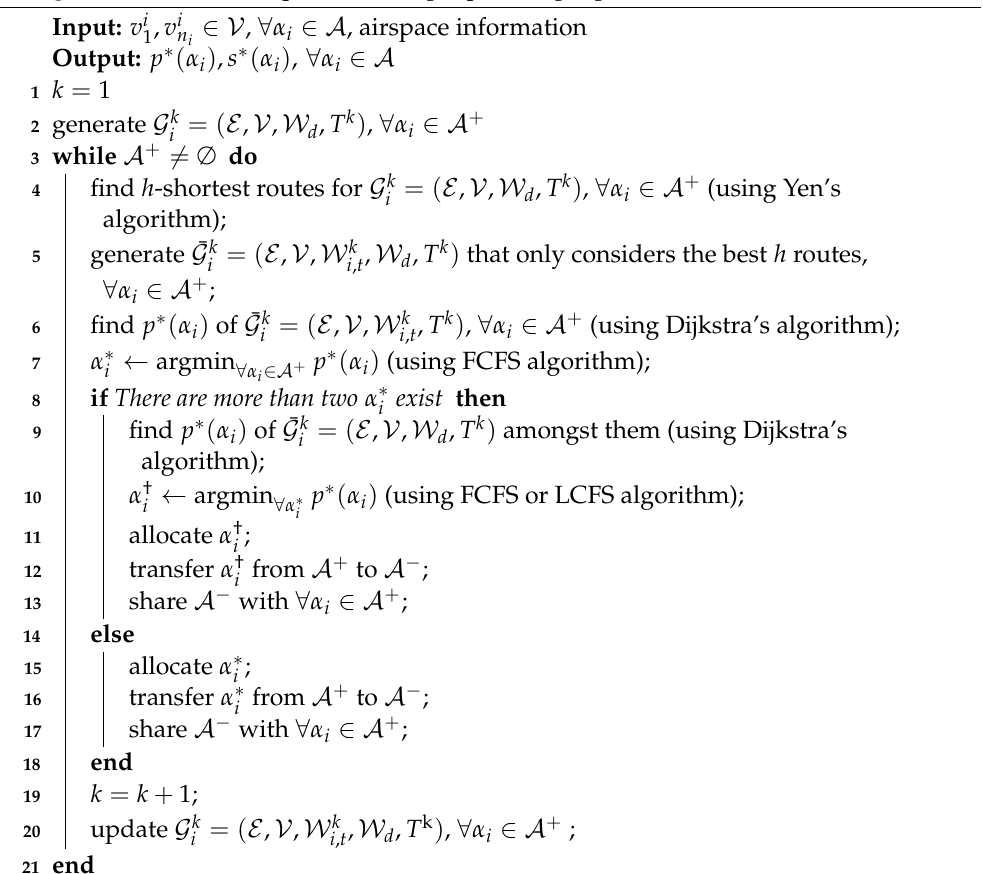
Algorithm 1: The multiple sUASs flight planning